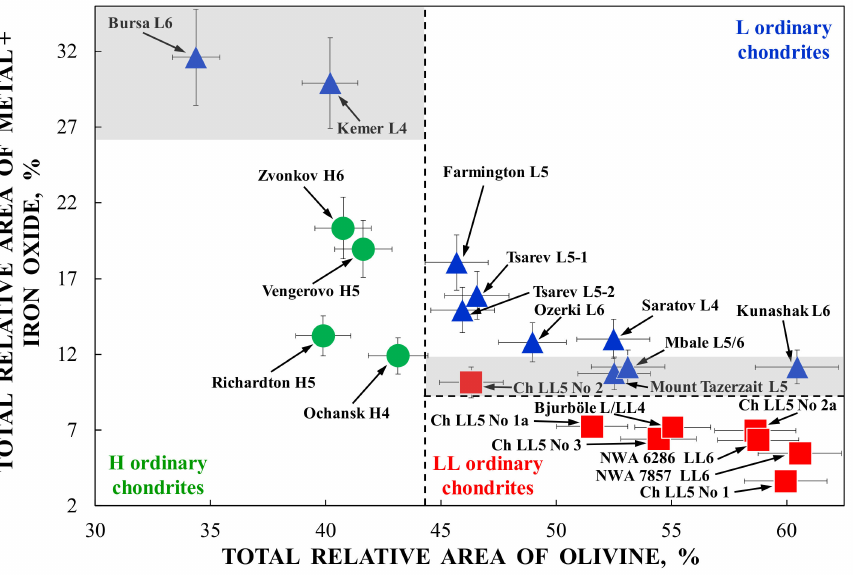
Figure 44. Classifications of H, L, and LL ordinary chondrites using the relative areas obtained from the Mössbauer spectra measured with a high velocity resolution: the total relative area of spectral components related to Fe-Ni-Co alloy plus ferric compounds vs. the total relative area of spectral components assigned to the M1 and M2 sites in olivine. Ch LL5 denotes different fragments of Chelyabinsk LL5 ordinary chondrite marked as No 1, No 1a, No 2, No 2a, and No 3. —H ordinary chondrites, —L ordinary chondrites, —LL ordinary chondrites. Grey zones indicate overlapping regions of (i) LL and L ordinary chondrites and (ii) L and H ordinary chondrites. Adapted from [107] with incorporation of new data from